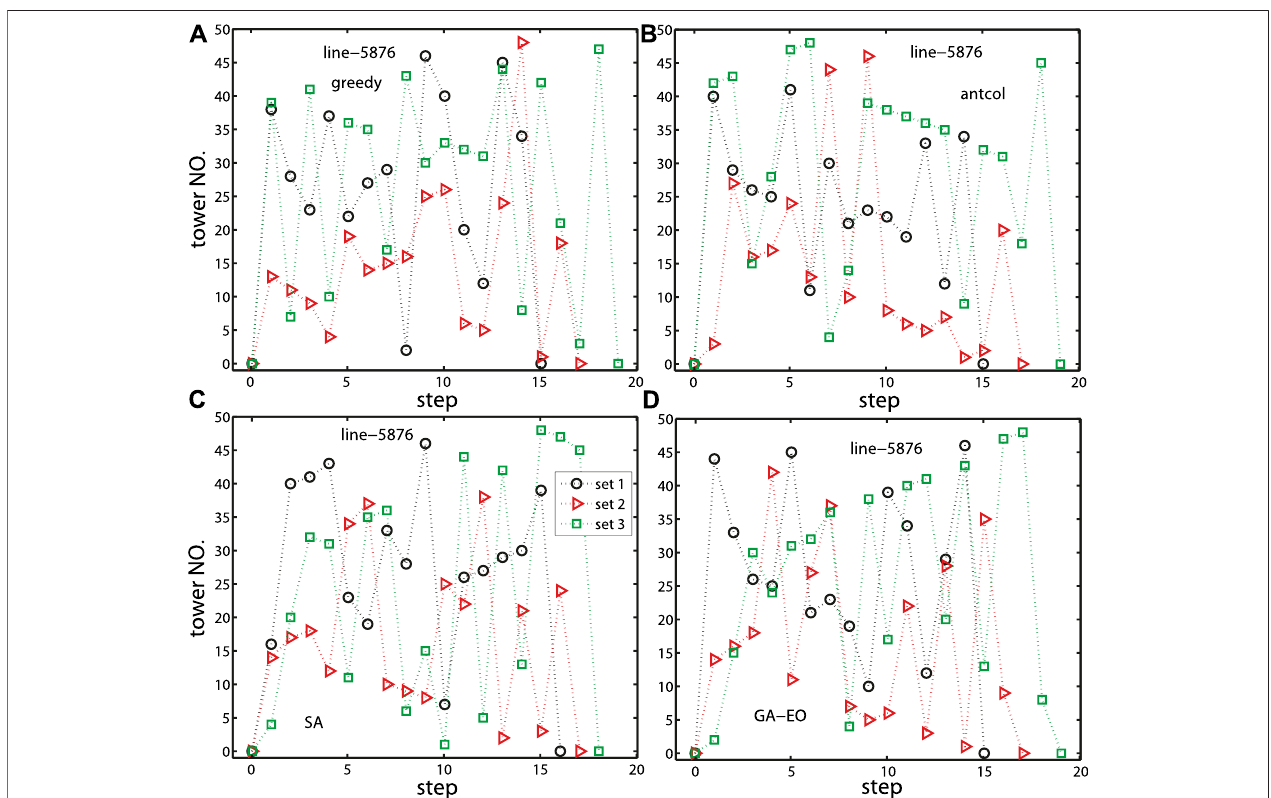
FIGURE 7 | (color online) Optimal inspection paths with our framework with (A) greedy, (B) antcol, (C) SA and (D) GA-EO. k = 3 for line-5876. p = 0.05 for the greedy algorithm. Here, the coordinate (0, 0) is the starting point, namely, the of fi ce.